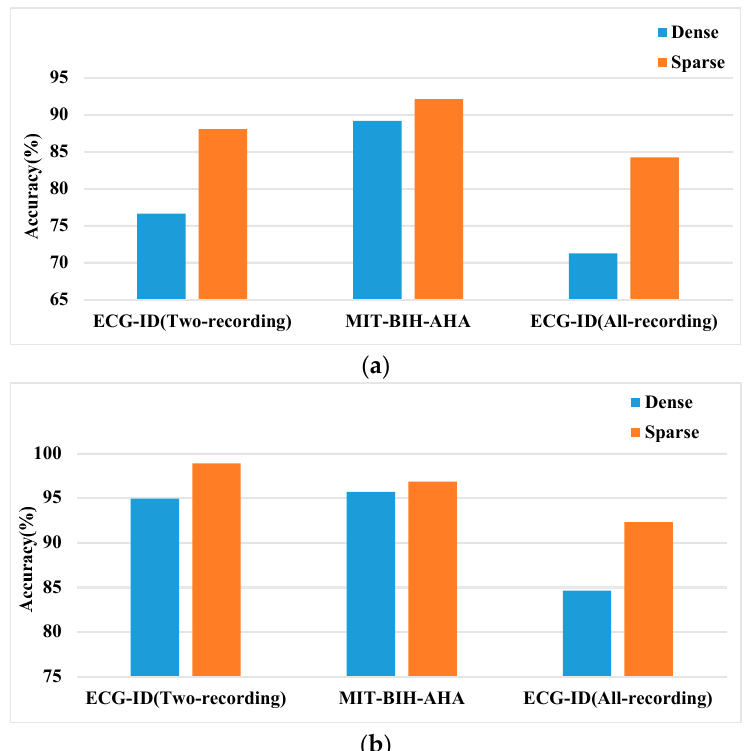
Figure 12. Comparison of the sparse and dense AEs. ( a ) Single-heartbeat identification accuracy; ( b ) Multiple-heartbeat identification accuracy.